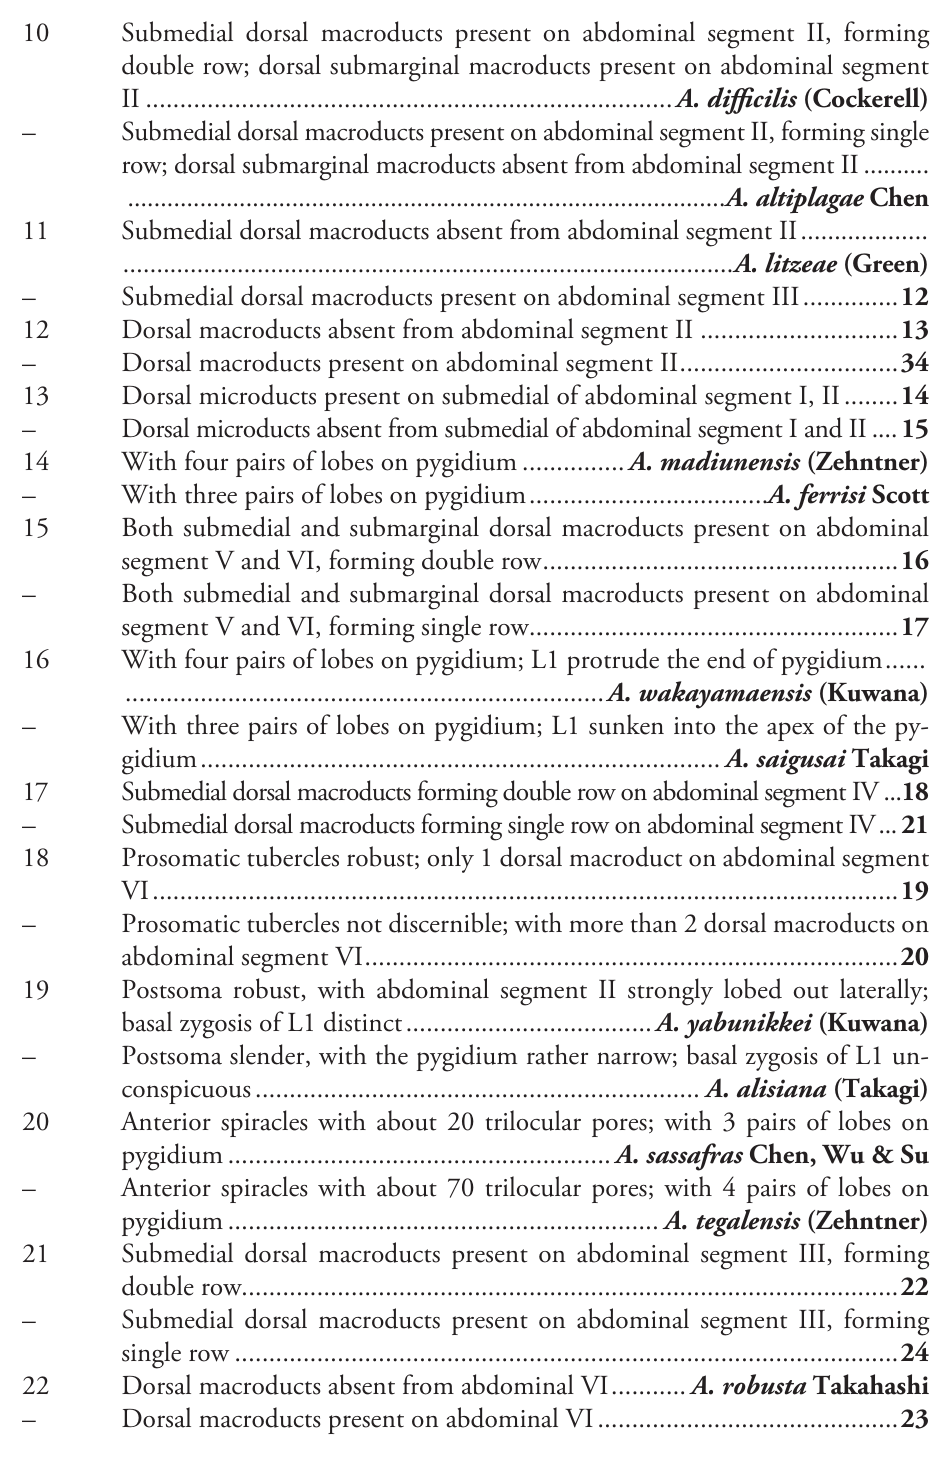
Both submedial and submarginal dorsal macroducts present on abdominal – Both submedial and submarginal dorsal macroducts present on abdominal With four pairs of lobes on pygidium; L1 protrude the end of pygidium ...... – With three pairs of lobes on pygidium; L1 sunken into the apex of the py- 17 Submedial dorsal macroducts forming double row on abdominal segment IV ... 18 – Submedial dorsal macroducts forming single row on abdominal segment IV ... 21 18 Prosomatic tubercles robust; only 1 dorsal macroduct on abdominal segment – Prosomatic tubercles not discernible; with more than 2 dorsal macroducts on 19 Postsoma robust, with abdominal segment II strongly lobed out laterally; basal zygosis of L1 distinct .................................... A. yabunikkei (Kuwana) – Postsoma slender, with the pygidium rather narrow; basal zygosis of L1 un- 20 Anterior spiracles with about 20 trilocular pores; with 3 pairs of lobes on – Anterior spiracles with about 70 trilocular pores; with 4 pairs of lobes on 21 Submedial dorsal macroducts present on abdominal segment III, forming – Submedial dorsal macroducts present on abdominal segment III,